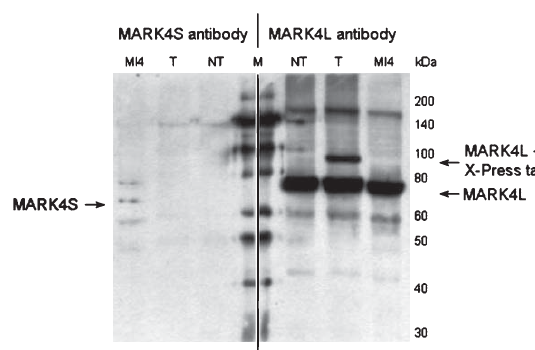
Supplementary Figure 3. The anti-MARK4S antibody does not recognize the over-expressed MARK4L protein. HEK293T cells were transfected with plasmid DNA encoding the fusion protein MARK4L+Xpresstag(laneT).Theanti-MARK4Lantibody(right) stains the endogenous MARK4L protein (lower band) and the over-expressed fusion protein (upper band). Signals from the anti- MARK4S antibody (left) are present only in the MI-4 lane, whereas in HEK293T cells, there is no evidence of MARK4S expression. Significantly, the anti-MARK4S antibody does not stain the over- expressed MARK4L protein in transfected HEK293T cells. The membrane was cut (black line) after the blocking step and incu- bated with the appropriate antibodies. MI-4, glioblastoma cell line; T, transfected HEK293T cells; NT, non-transfected HEK293T cells; M, molecular weight ladders